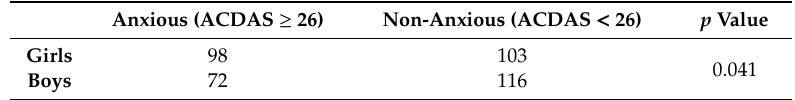
Table 3. Distribution of dental anxiety according to gender, based on ACDAS scores (statistical analysis with Fisher’s exact test).